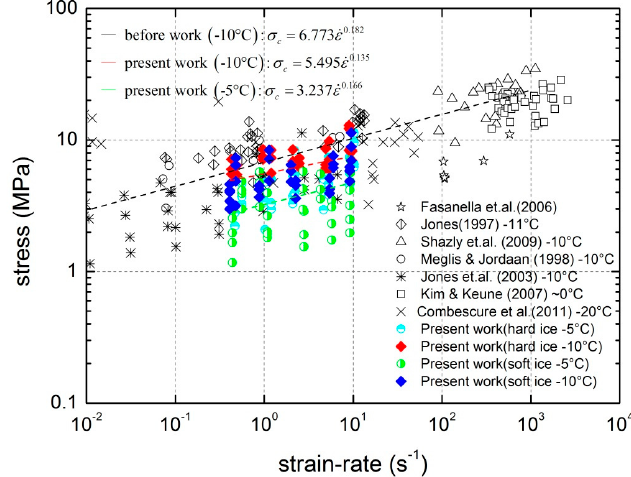
Figure 18. Uniaxial compressive strength results of present and some previous work. Solid marks denote results of the present work and hollow marks denote results of some previous studies of other